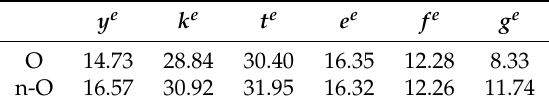
Table 4. Equilibrium